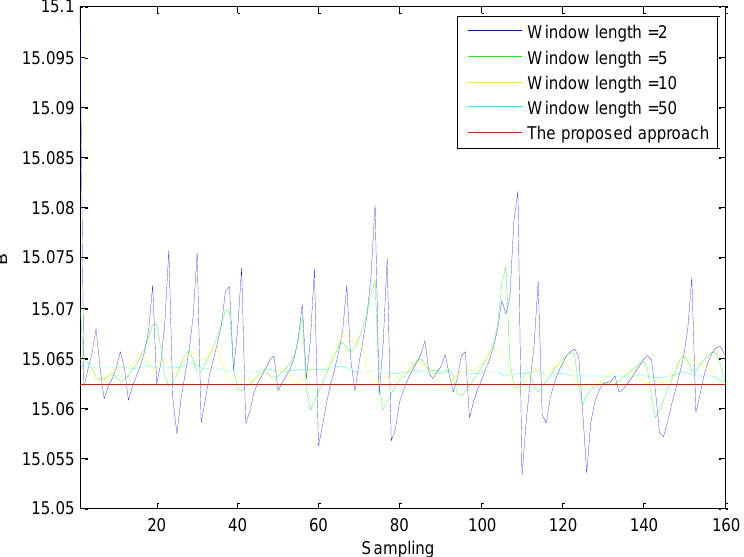
Figure 16. The comparison between the slide window and the proposed approach.